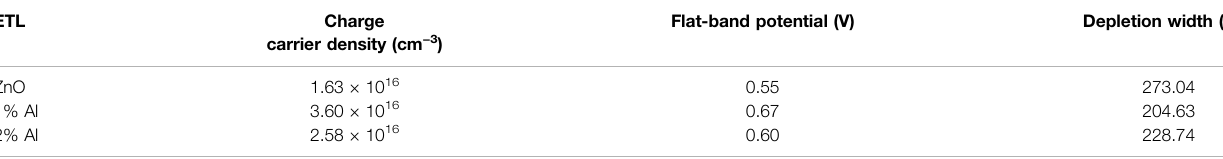
TABLE 4 | MS data of samples.